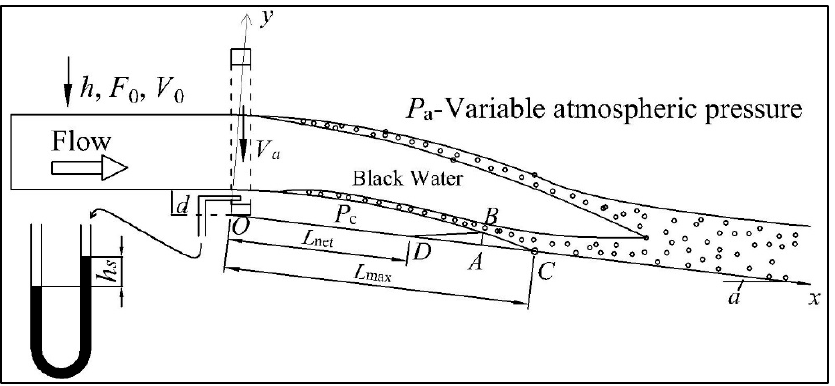
Figure 1. Definition scheme with the model.